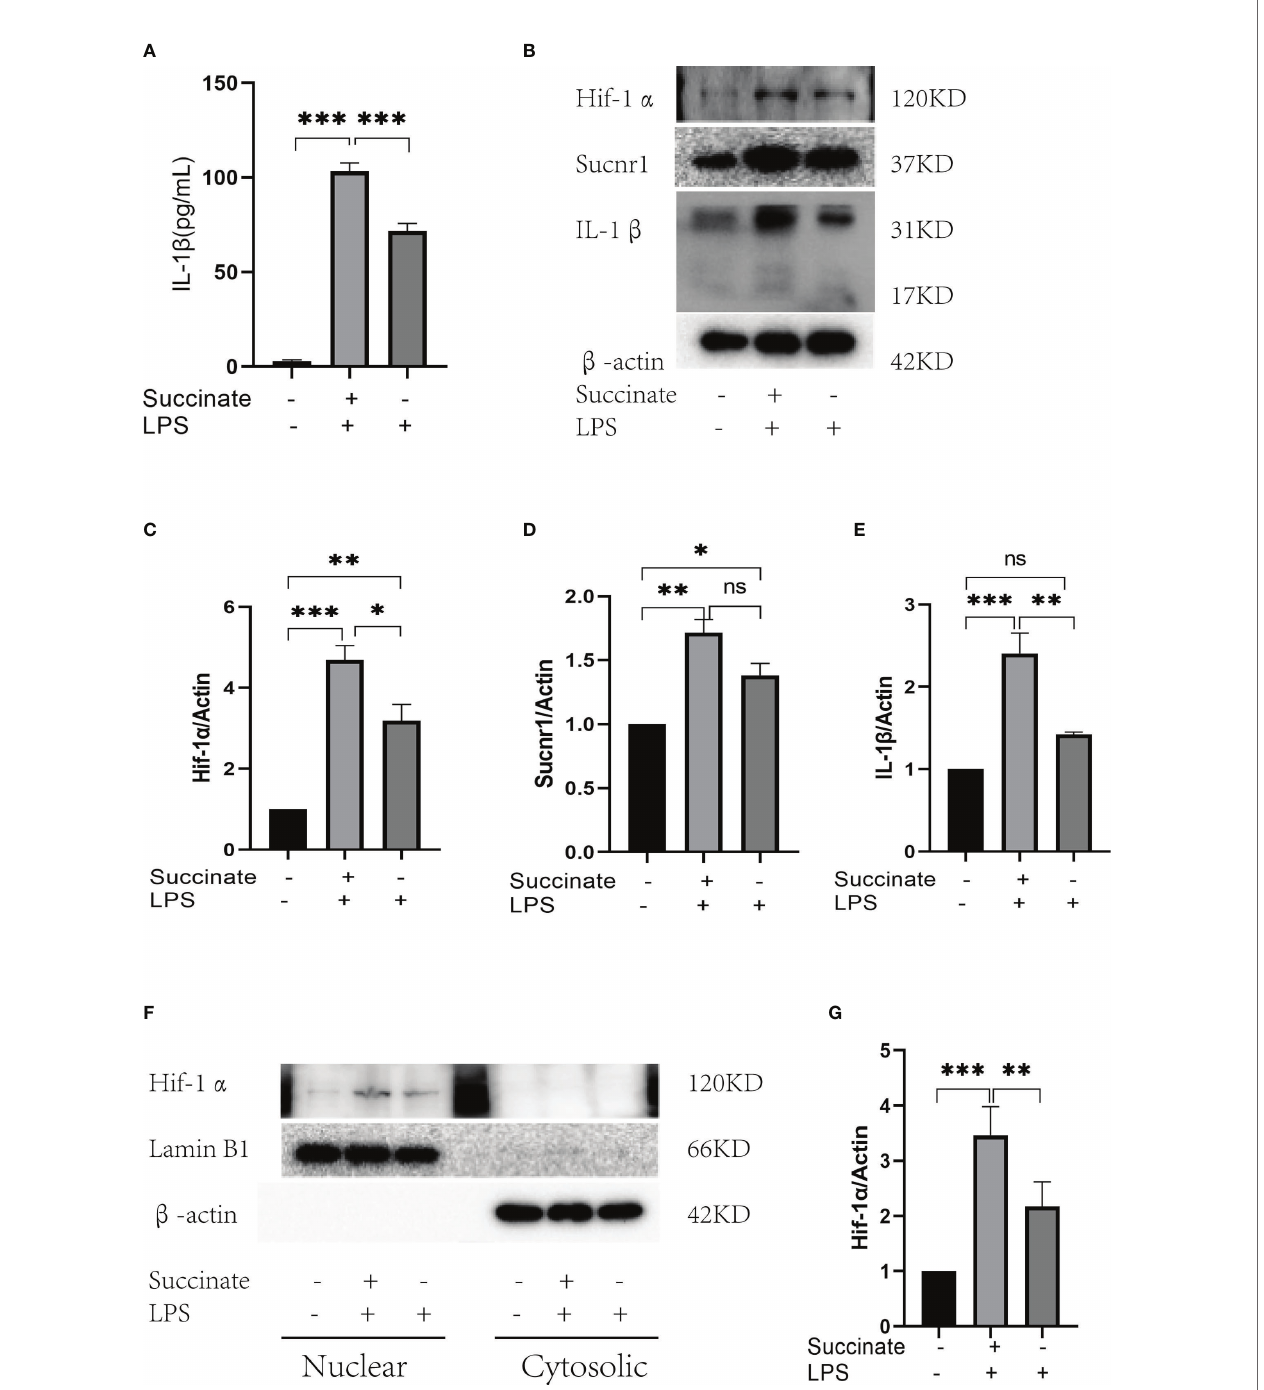
FIGURE 2 | Sucnr1/Hif-1 a /IL-1 b signal axis in HUVECs. HUVECs were divided into three groups and given intervention according to design: Blank control was given equal amount of PBS, LPS+succinate group was given LPS (100 ng/ml) and succinate (800 m M), and LPS group was given LPS (100 ng/ml) for 24-h intervention, then supernatant medium and proteins were collected for experiment. (A) IL-1 b of supernatant medium was detected via ELISA. (B – E) Expression levels of Sucnr1, Hif-1 a , and IL-1 b were displayed via Western blots and analyzed graphs. (F, G) Expression levels of Hif-1 a in nucleus were detected using Western blots, in which Lamin B1 was the reference protein. Western blot data present mean ± SEM from three independent experiments at least. ELISA results represent mean ± SD from three different experiments at least. * P < 0.05; ** P < 0.01; *** P < 0.001; ns means no statistical